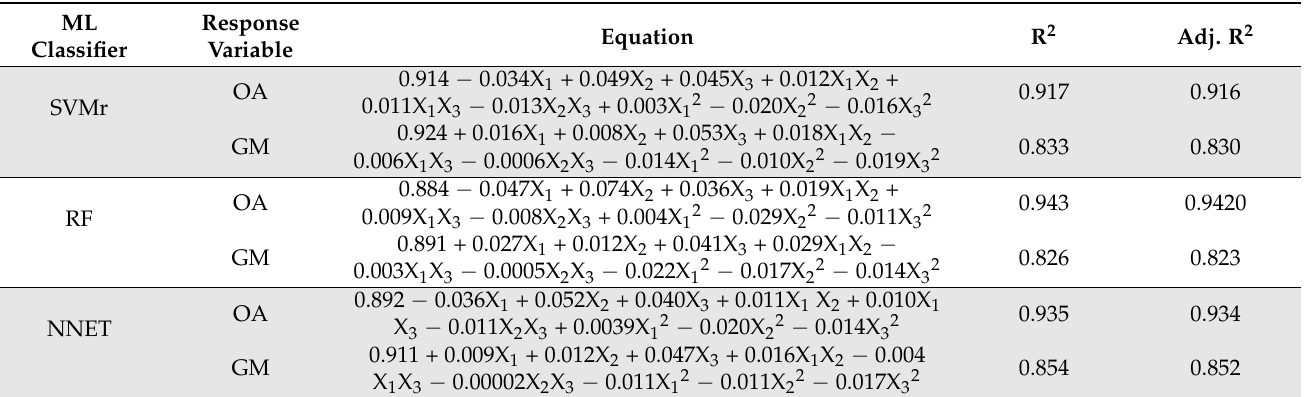
Table 5. Best fit of the quadratic equation for each classifier and each response variable. The independent variables X 1 , X 2 , and X 3 are the coded values for the number of tomato training sites, the number of ‘other crops’ training sites, and lead